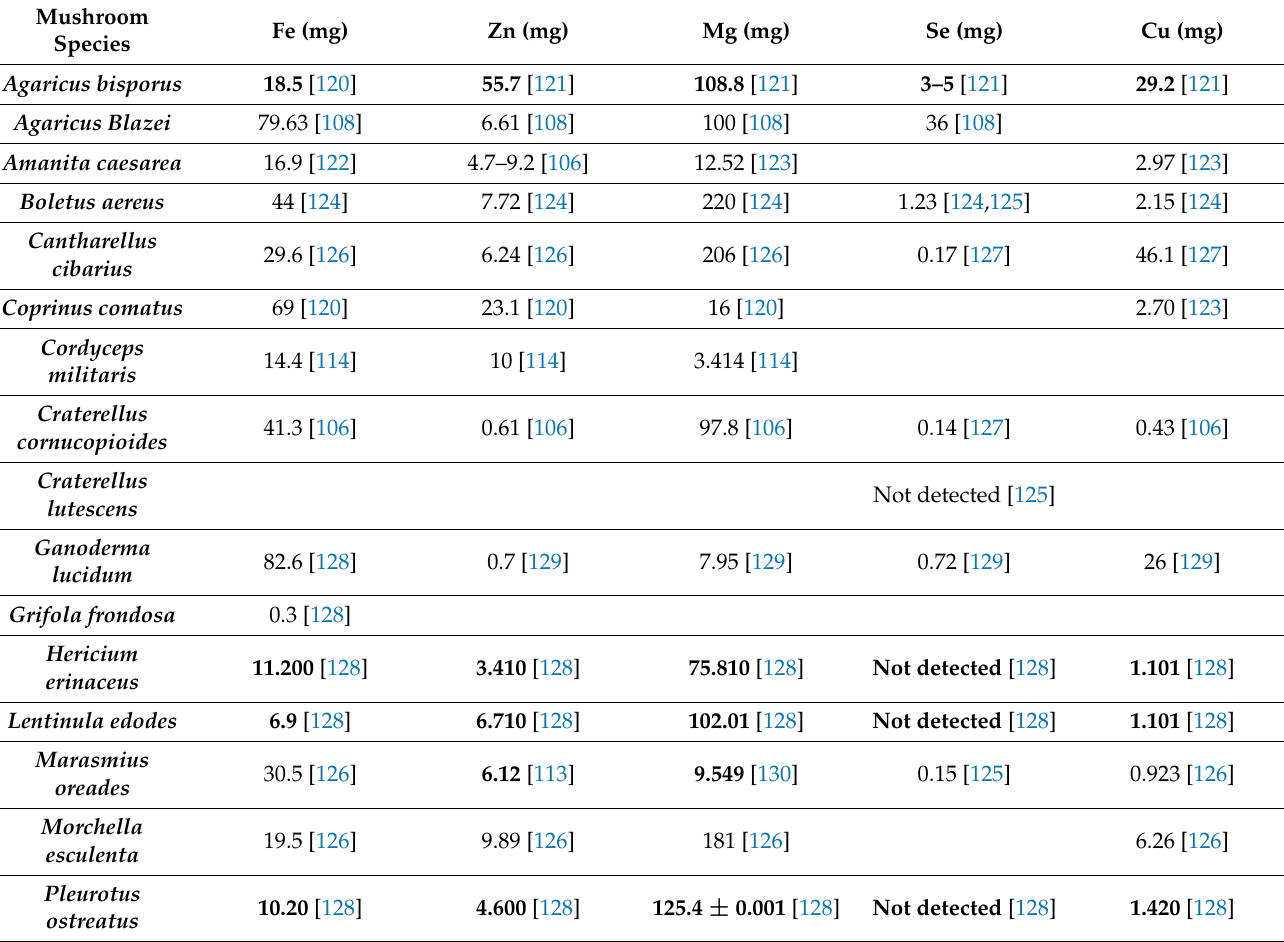
Table 3. Major essential, non-essential, and toxic element concentrations (mg/100 g on dry weight basis) in sixteen species of